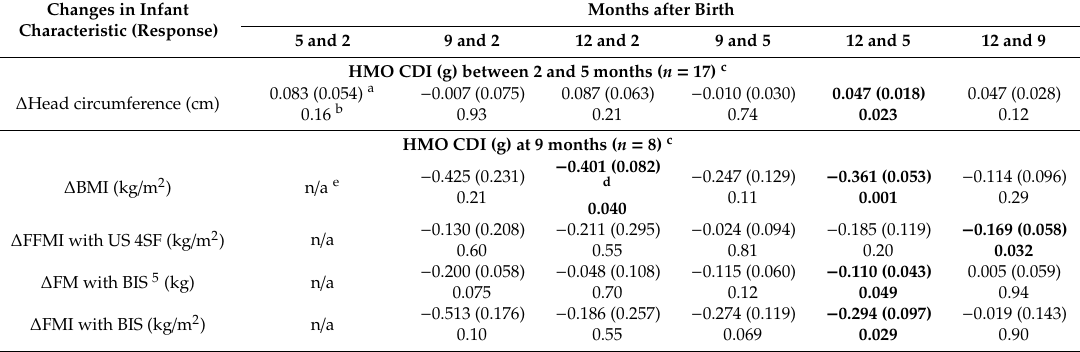
Table A4. Associations of calculated daily intakes of total carbohydrates at the time points with changes in infant body composition between the time